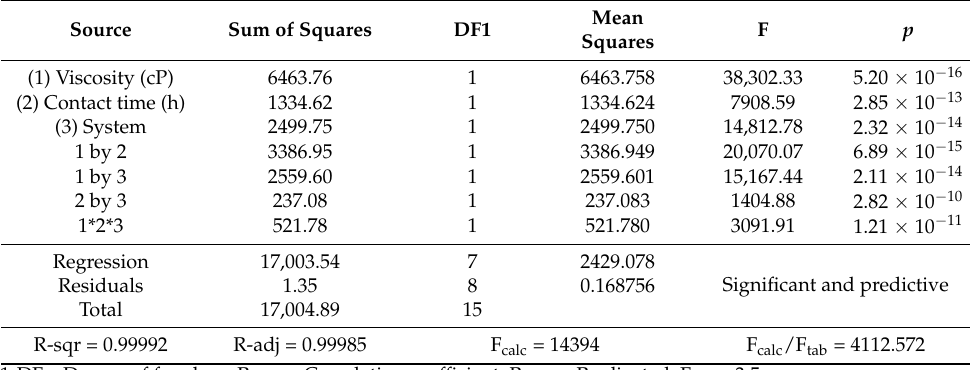
Table 3. Analysis of Variance